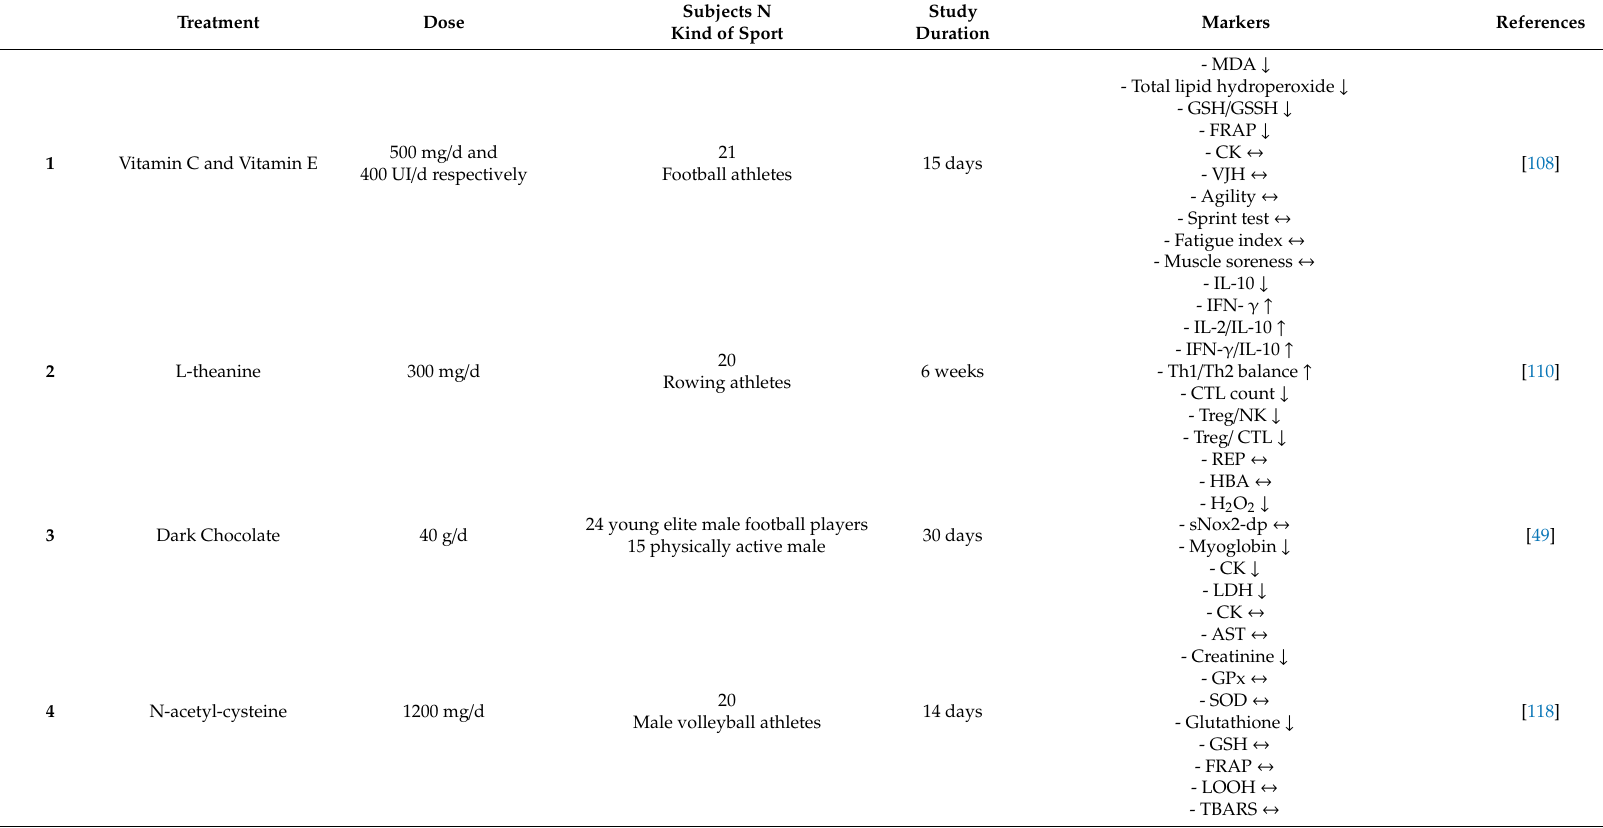
Table 2. E ff ects of antioxidant supplementation in Athletes. Main characteristics and main results of intervention